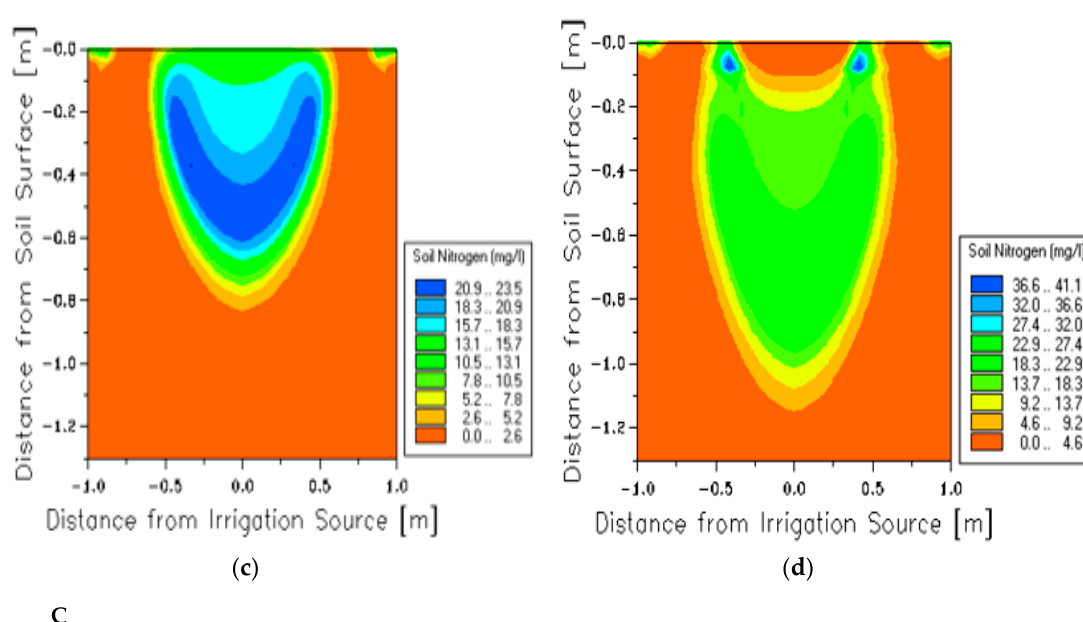
Figure 4. A ( a – d ). The distribution soil moisture through stages ( a – d ) of growth in the soil profile under partial root drying for potato crops at 100% of ETc, produced by SALTMED model version 2020. B ( a – d ). The distribution of soil salinity through stages ( a – d ) of growth in the soil profile under partial root drying for potato crops at 100% of ETc, produced by SALTMED model version 2020. C ( a – d ). The distribution of soil nitrogen through stages ( a – d ) of growth in the soil profile under partial root drying for potato crops at 100% of ETc, produced by SALTMED model version 2020.